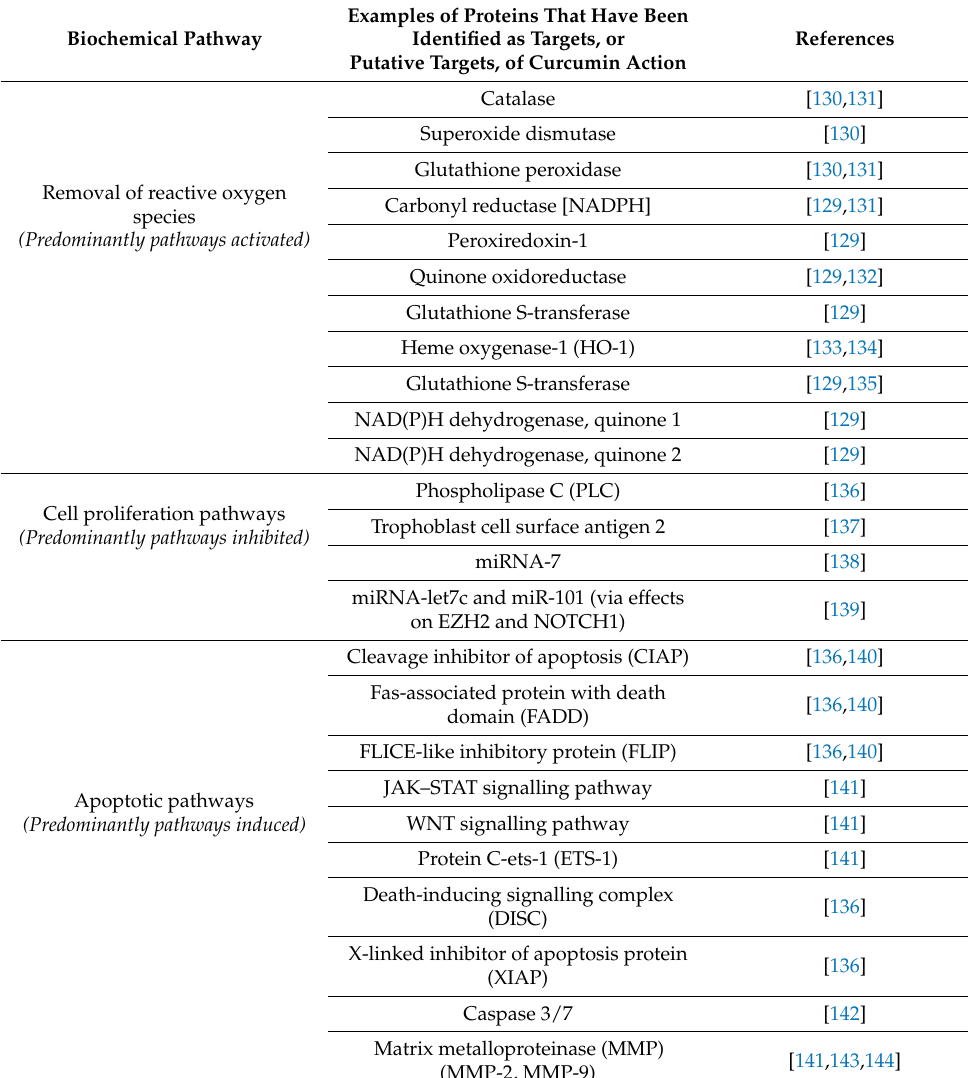
Table 2. Biochemical and signalling pathways in animal cells known to be affected by curcumin ((1E,6E)-1,7-bis(4-hydroxy-3-methoxyphenyl)-1,6-heptadiene-3,5-dione), and some proteins which have been identified as targets, or putative targets, modified by